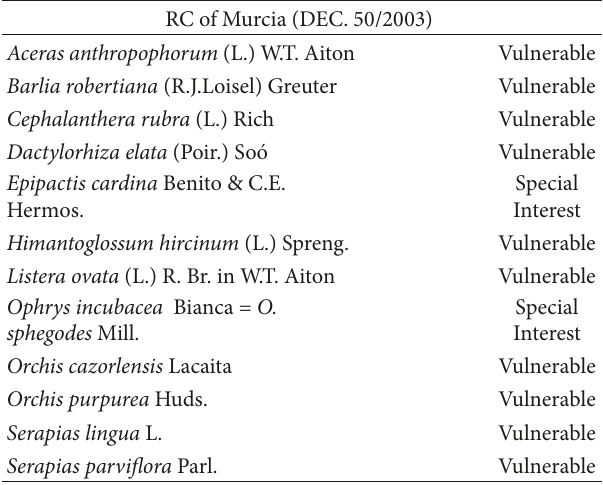
Table 19: Species included in the regional catalogue (RC) of Murcia (DEC. 50/2003).